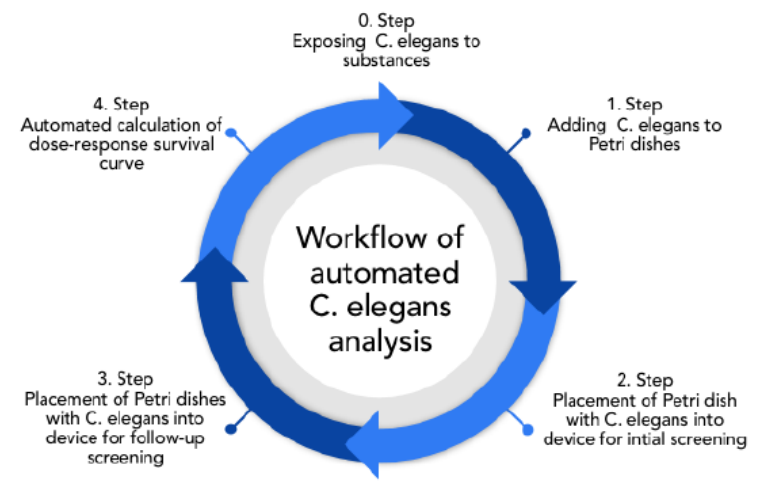
Figure 1. Intended workflow for automated C. elegans